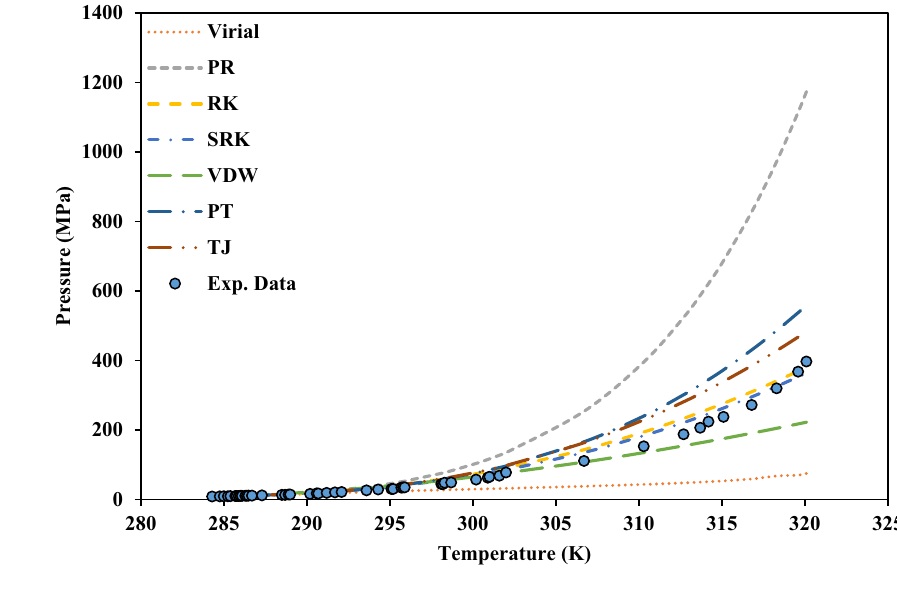
Fig. 5 Comparison between dif- ferent EOSs used in VdW-P for 284.3 ≤ T ≤ 320.1 K